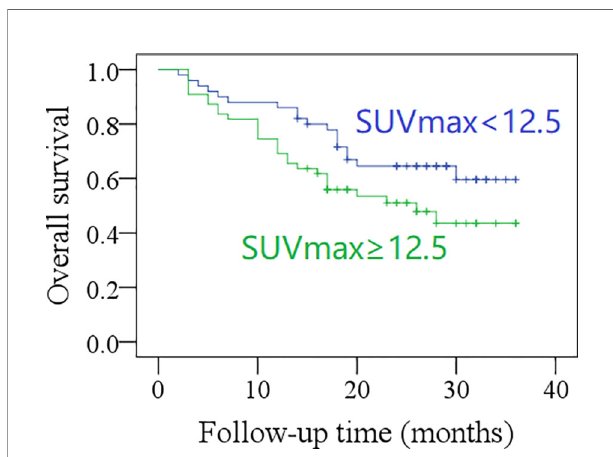
FIGURE 4 | Comparison of overall survival in patients with different total maximum standard uptake values (SUVmax) ( p